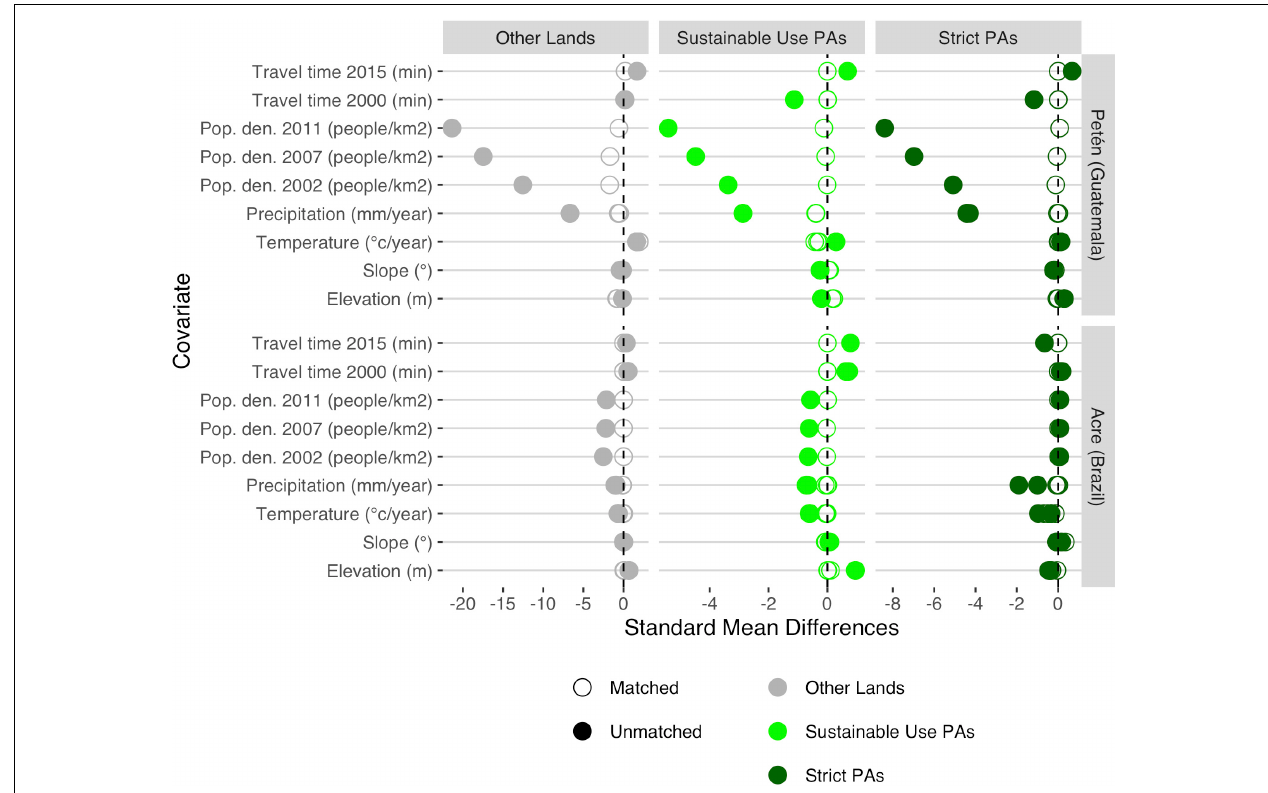
FIGURE 2 | Covariates standard mean differences between Community Managed PAs and Other Lands, Sustainable Use PAs, and Strict PAs before (Unmatched) and after matching analysis (Matched) in the Petén (Guatemala) and Acre (Brazil).